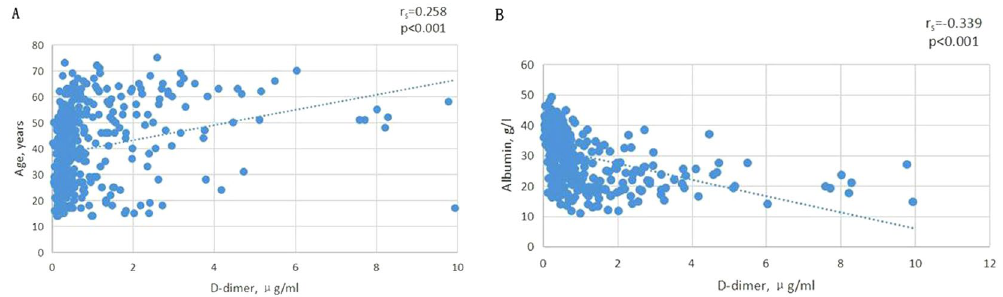
Figure 2. Scatter diagram for the correlation of D-dimer with age and albumin. ( A ) Positive correlation of D-dimer level with age. ( B ) Negative correlation of D-dimer level with